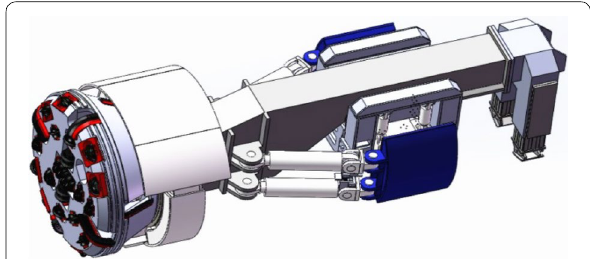
Figure 1 Structure of open type hard rock TBM